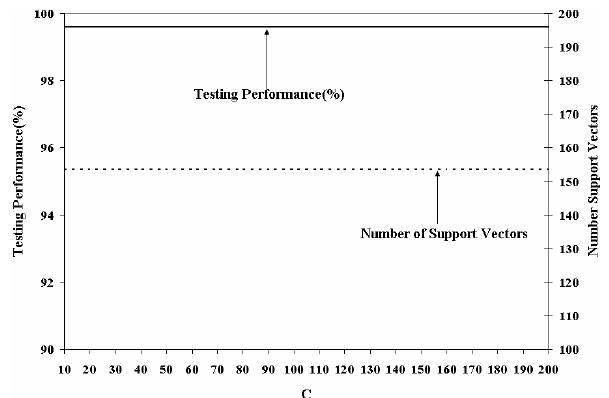
Figure 13. Variation of Testing Performance (%) and Number of Support Vectors with C Fig. 13. Variation of Testing Performance (%) and Number of values for MODEL II using radial basis function kernel. Support Vectors with C values for MODEL II using radial basis function kernel.